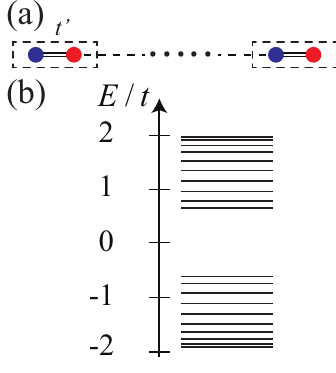
Figure 5. ( a ) Finite-length dimer chain with unit cell containing two carbon atoms connected by double bond. The intra cell hopping t (cid:48) is larger than the inter cell hopping t . Note that the unit cell is different from that shown in Figure 4. ( b ) Energy spectrum. No gap states